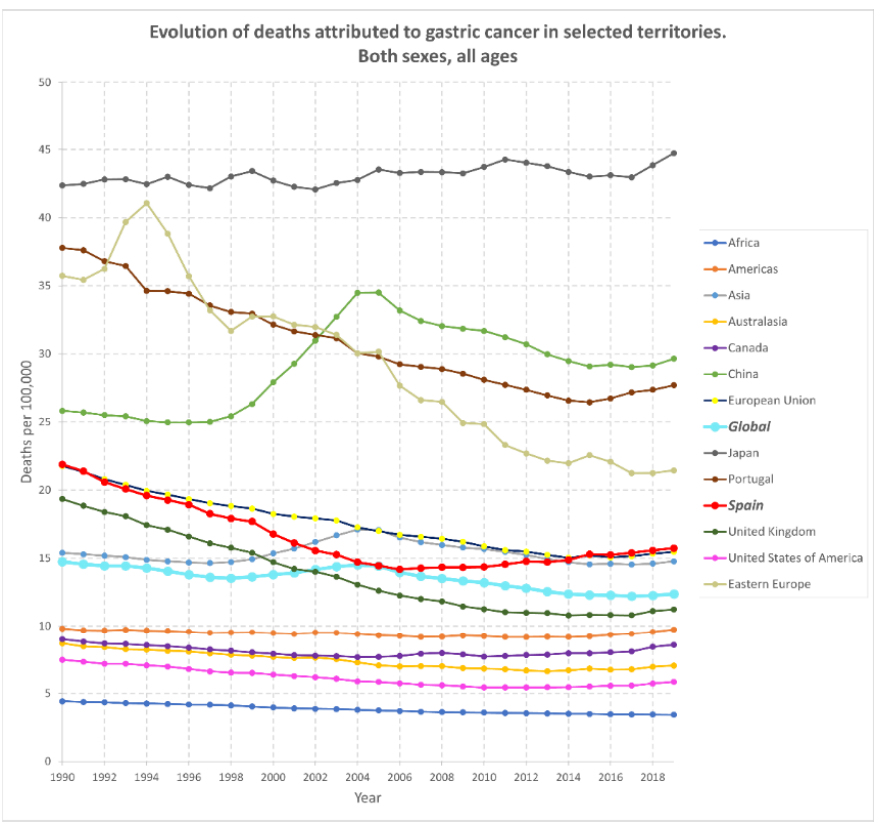
Figure 2. Evolution of deaths attributed to gastric cancer in selected territories (both sexes, all ages). Data obtained from Ref. [1]. 2019, Institute for Health Metrics and Evaluation (IHME), University of Washington.